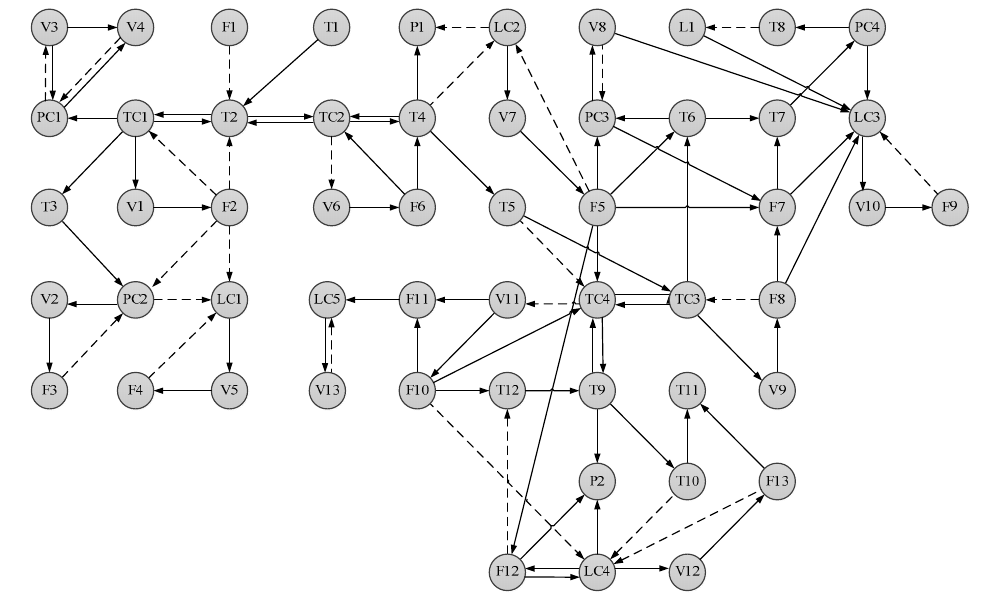
Figure 12. SDG of hydrogenation prefractionation system.